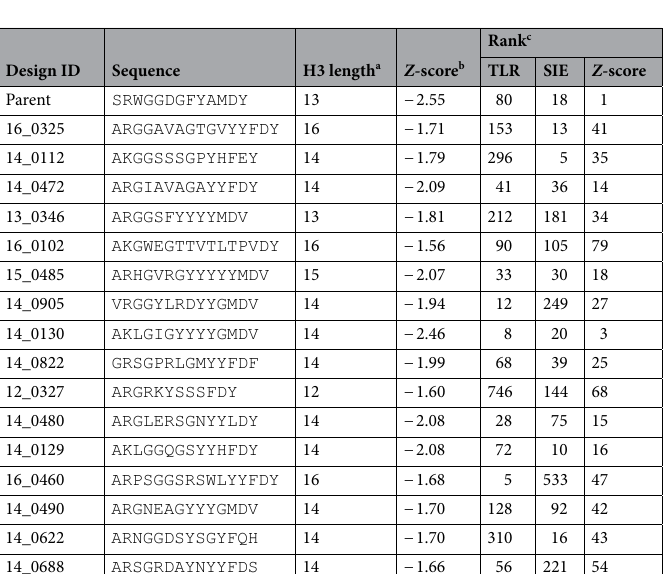
Figure 4. Antibody–antigen binding affinity scoring protocol. The antibodies with their modeled H3 loop ensembles are scored for antigen binding using SIE and Talaris energies combined into a consensus score. This model is used to rank the best designs. Visual inspection is then used to remove candidates that have obvious flaws in internal geometry and/or intermolecular interactions.